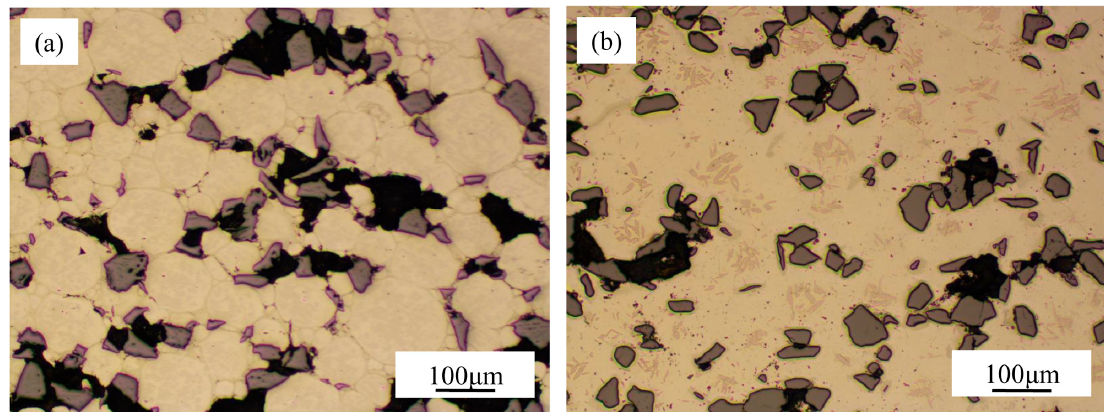
Figure 2. Optical microscopy images of specimens produced at ( a ) 900 °C and ( b ) 1400 °C.